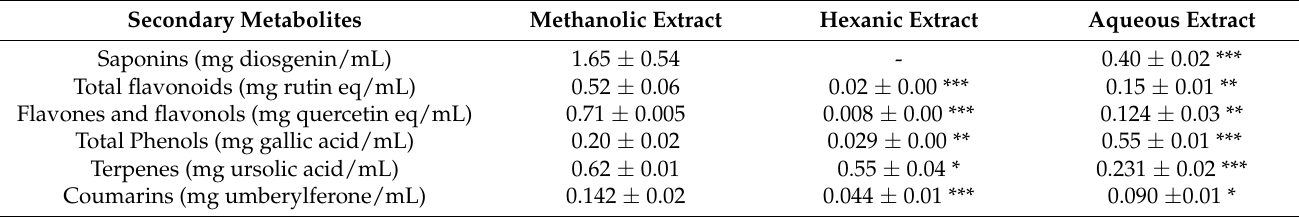
Table 2. Quantitative analysis of secondary metabolites of the organic and aqueous extracts of P. alliacea L.